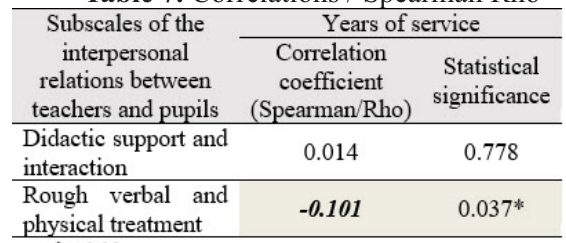
Table 7. Correlations / Spearman